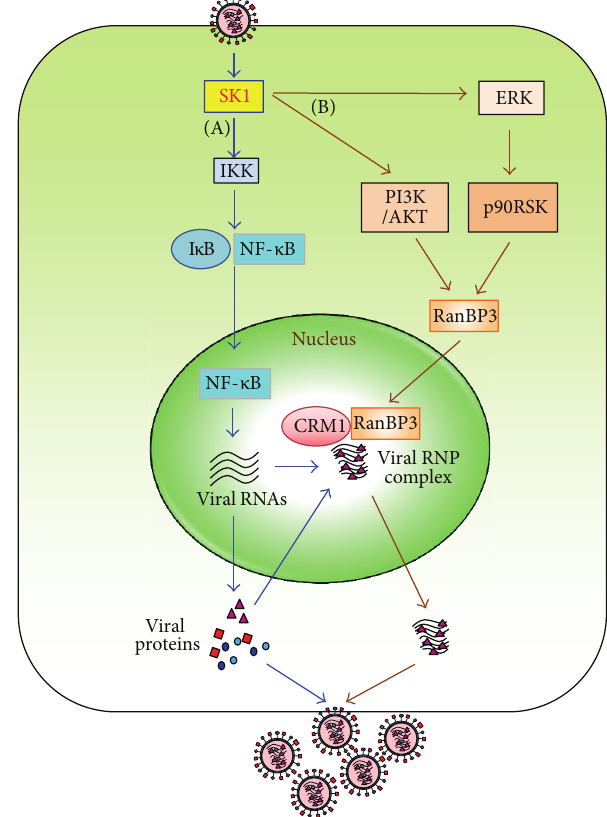
Figure 3: Model for the proviral function of SK1 in influenza virus replication. The figure is adapted from Seo et al.